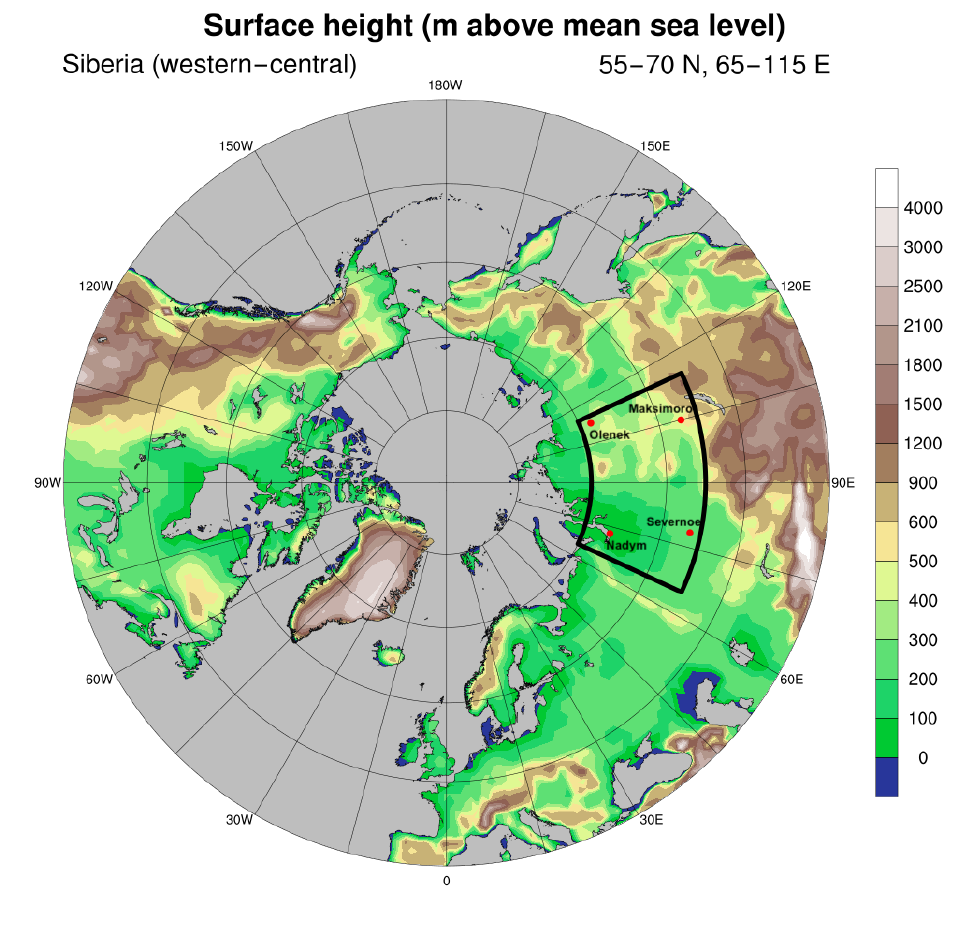
Figure 1. Orography with height in meters of the Northern Hemisphere ( ≥ 40 ◦ N). The black box (55–70 ◦ N, 65–115 ◦ E) shows western–central Siberia, further referred to as Siberia. Red dots indicate the location of the four stations: Nadym (66.47 ◦ N, 72.67 ◦ E), Olenek (68.50 ◦ N, 112.43 ◦ E), Maksimoro (57.10 ◦ N, 104.97 ◦ E), and Severnoe (56.35 ◦ N, 78.35 ◦